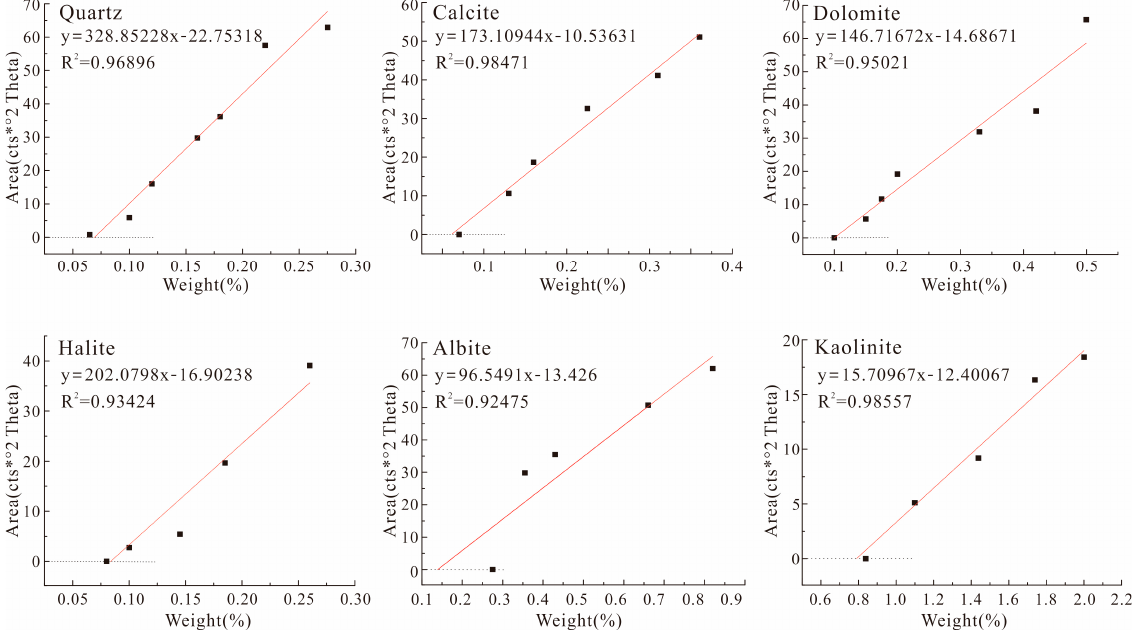
Figure 2. Regression analysis of the content of each mineral and the characteristic peak area. The net integral area of peak is calculated by HighScore during fi tt ing, cts = cps* counting time.